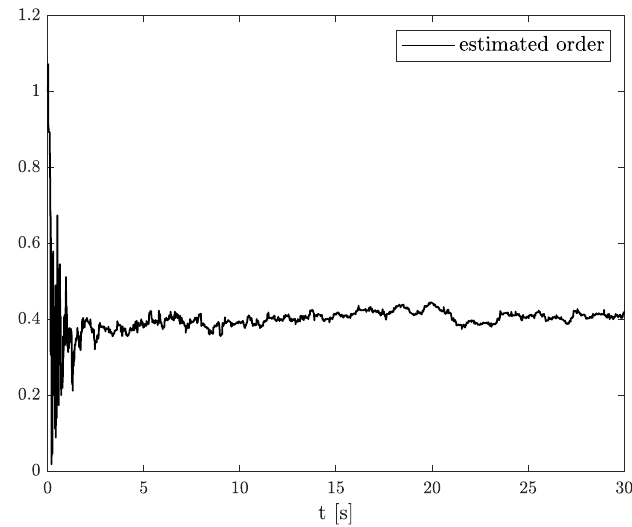
Figure 19. Order estimation for z -axis noise.